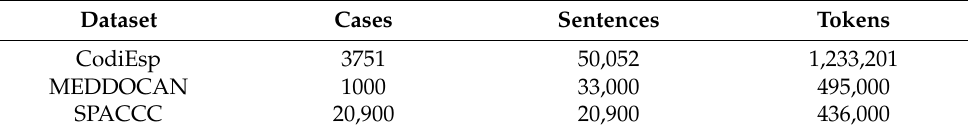
Table 2. Size of the Spanish medicine